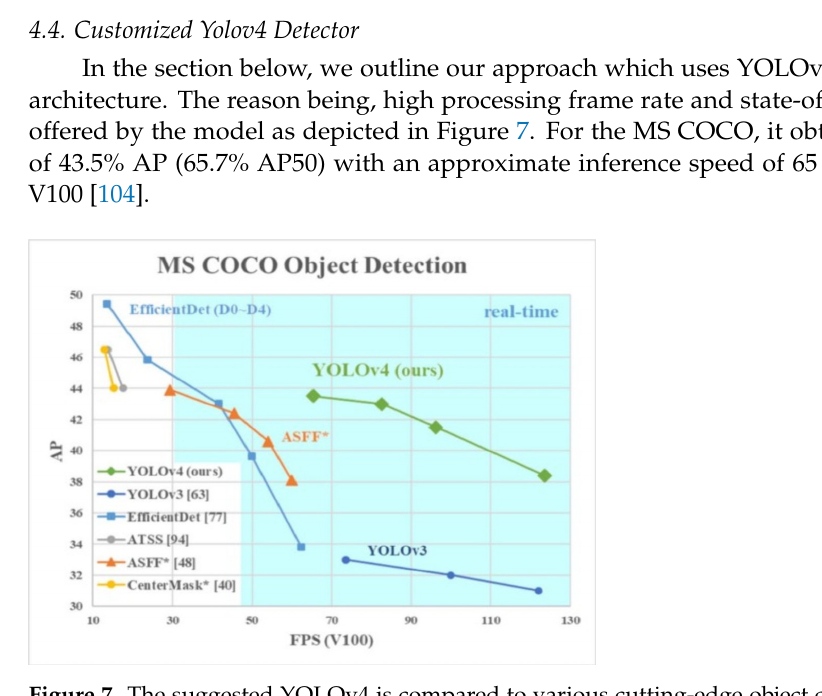
Figure 7. The suggested YOLOv4 is compared to various cutting-edge object detectors. YOLOv4 performs equally well as EfficientDet while operating twice as quickly, increases the AP and FPS of YOLOv3 by 10% and 12%,